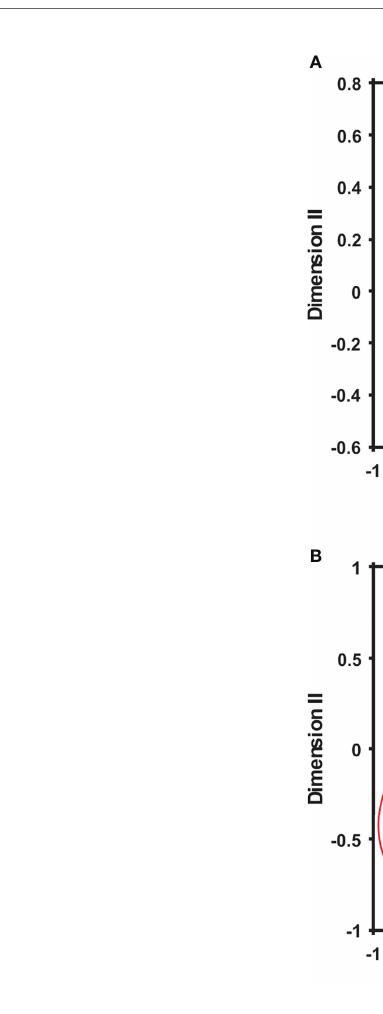
FIGURE 4 | Two-dimensional Nonmetric Multidimensional Scaling (NMDS) analysis of regional variation based on (A) COI sequence numbers and (B) EcoMon morphological counts for 6 taxonomic groups: Calanoida, Cyclopoida, Eucarida, Gastropoda, Hydrozoa, Chaetognatha. The plot indicates the year of sample collection; colors indicate regions: MAB (red), GB (green), GoM